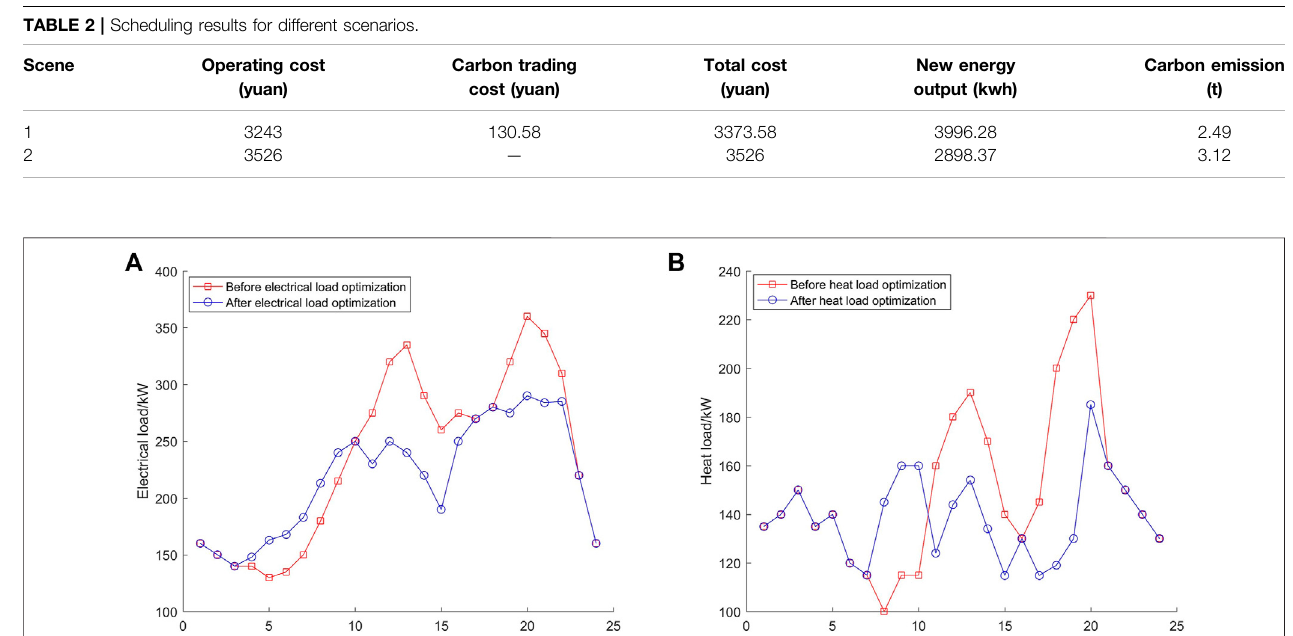
FIGURE10 | Scenario 1:Electricheatingload response curve before and after optimal scheduling. (A) Beforeoptimal scheduling and (B) after optimal scheduling.